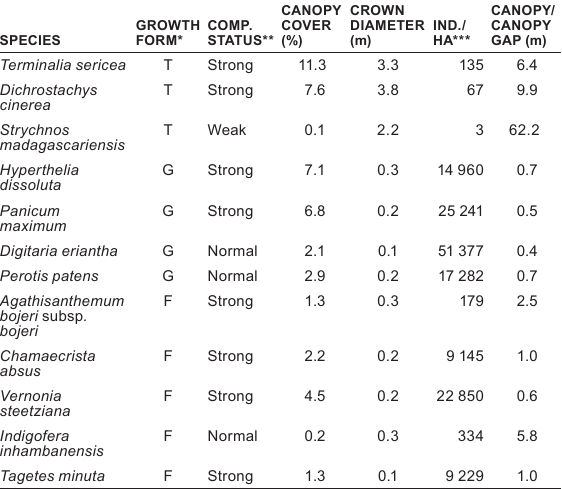
table 7 Species and growth form relations in Community 2